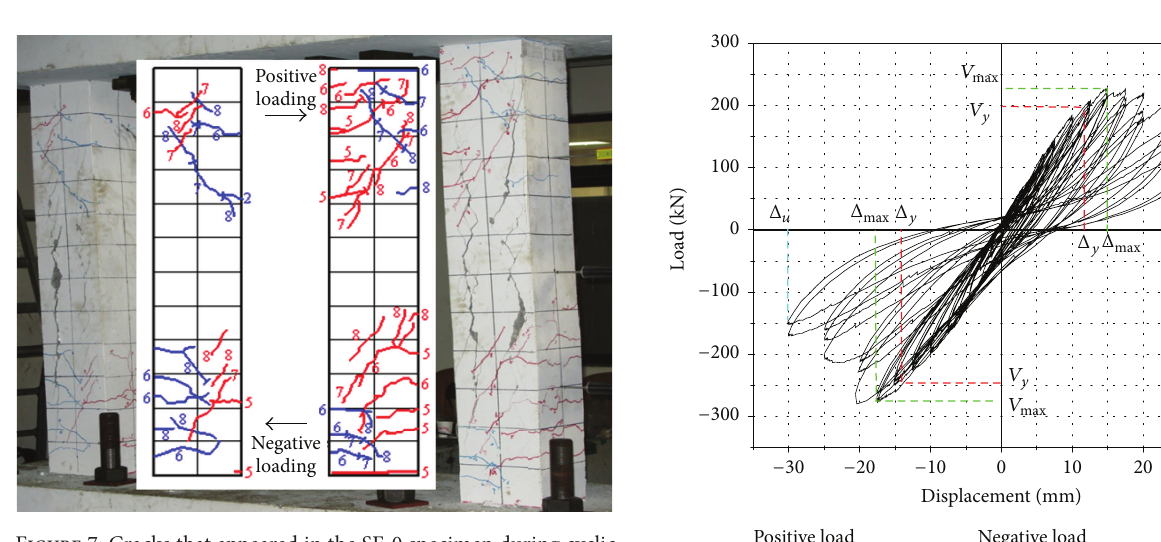
Figure 7: Cracks that appeared in the SF-0 specimen during cyclic loading.